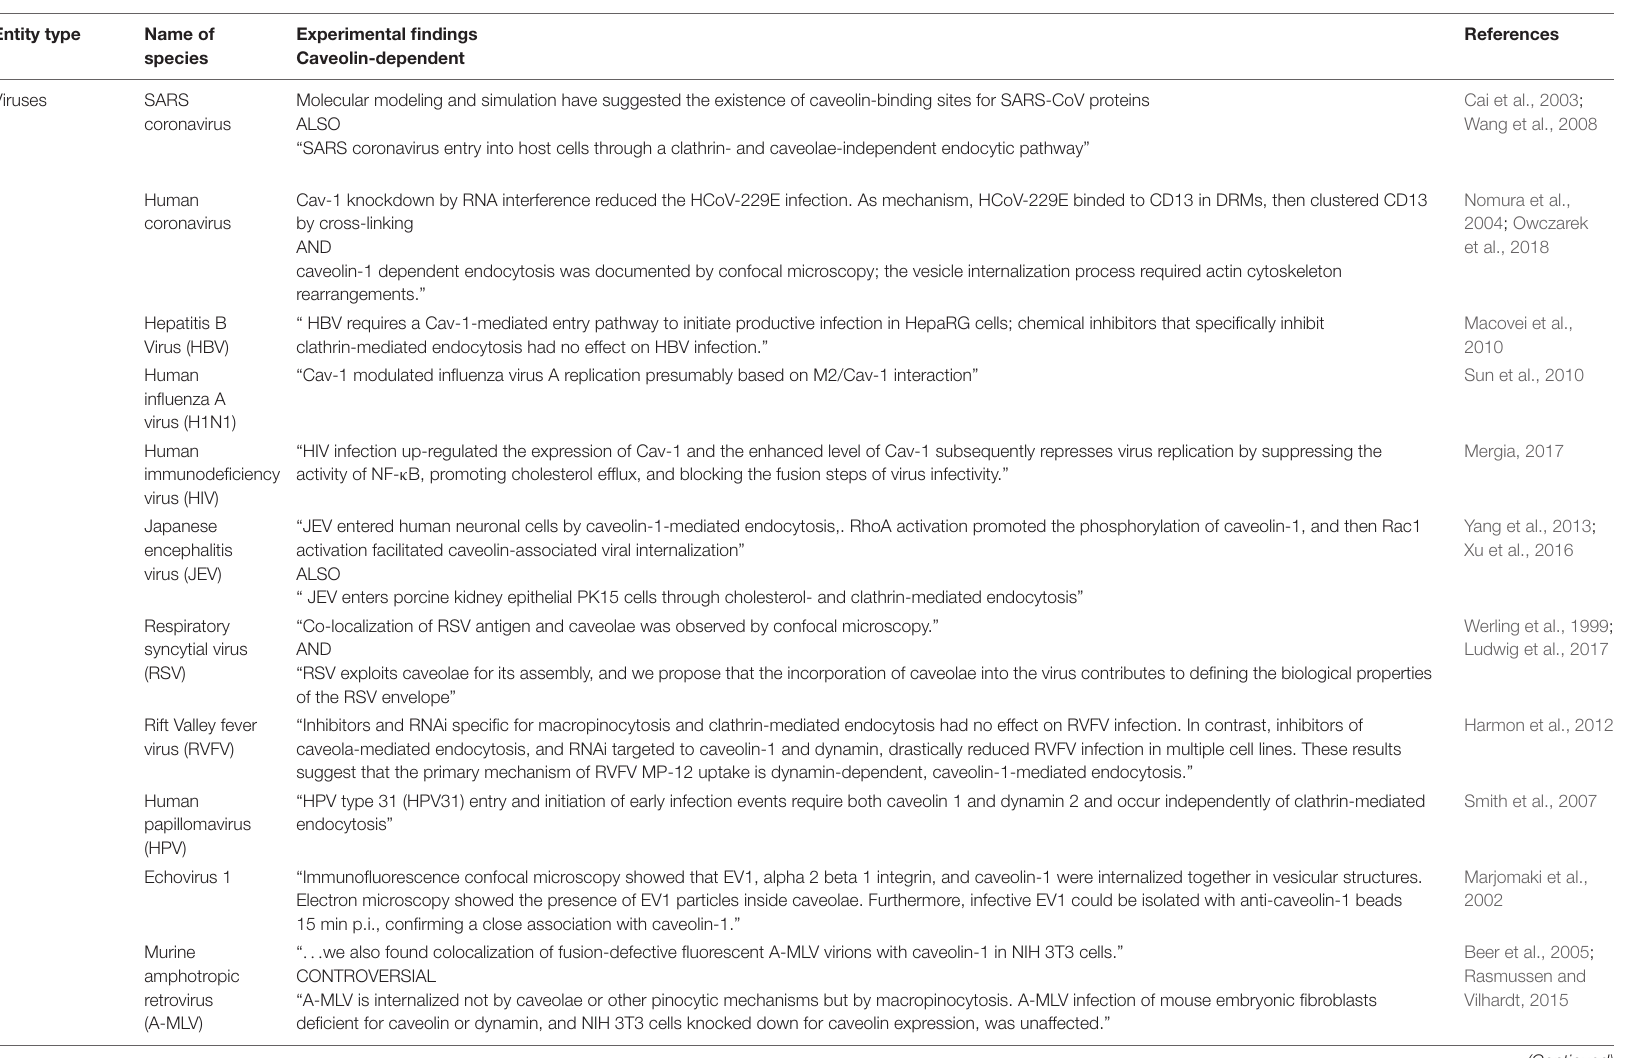
TABLE 1 | Summarization of pathogens using caveolae as entry